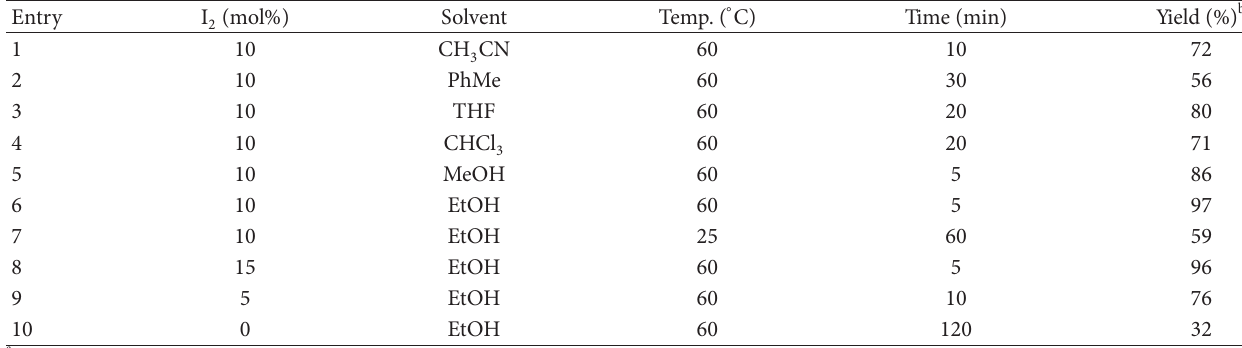
T 1: Optimization studies of the condensation of isatin with malononitrile a .